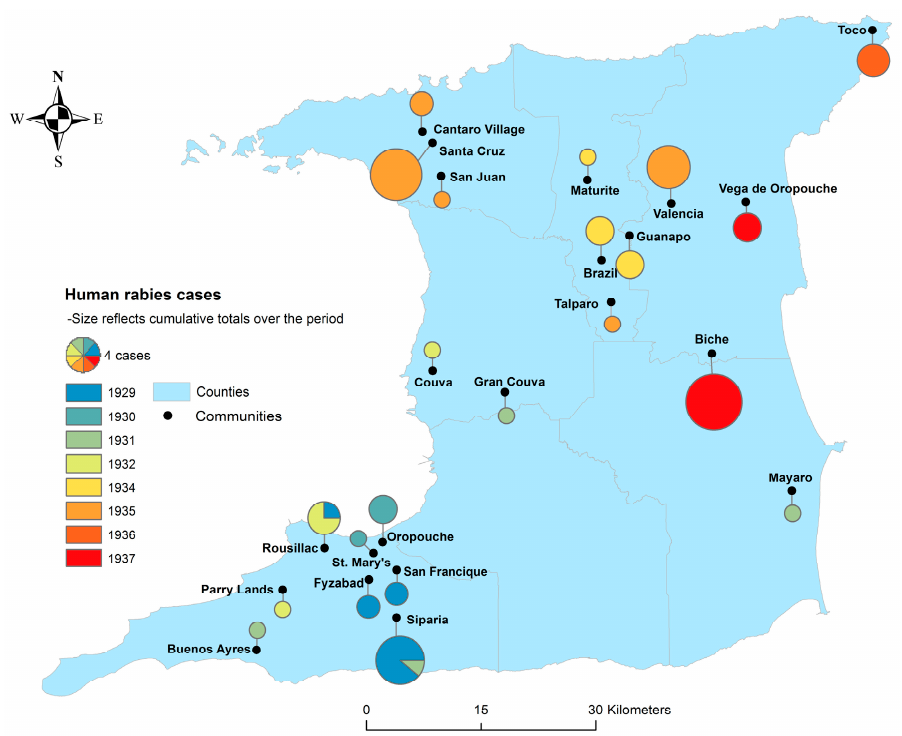
Figure 1. Geographic locations and number of cases by year for bat-transmitted human rabies cases in Trinidad during the period of 1929–1937.